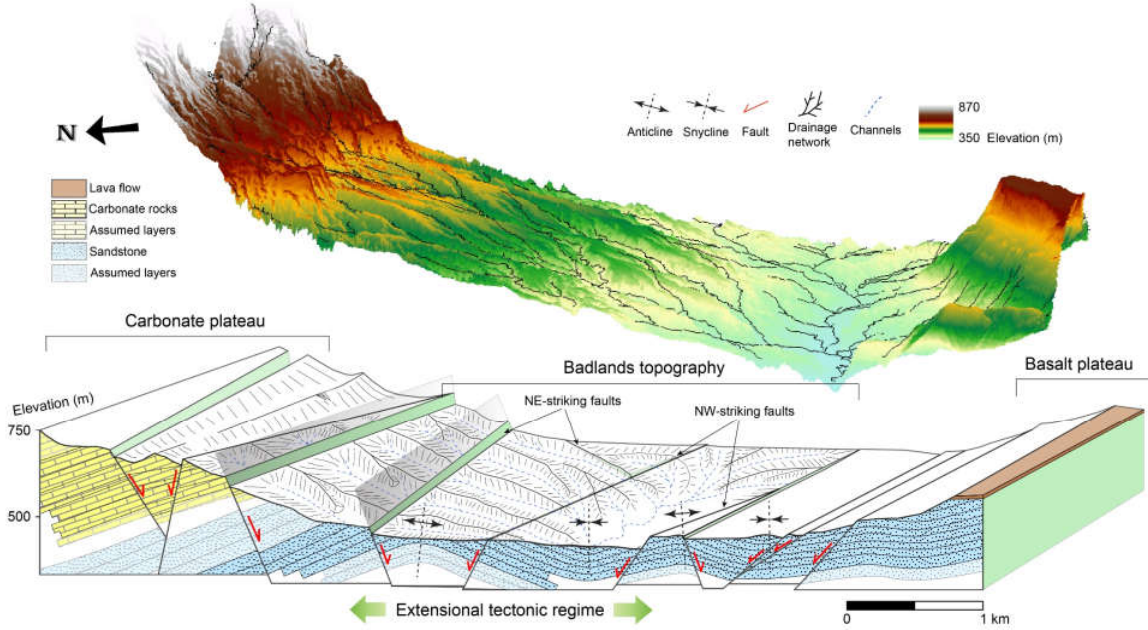
Figure 14. Tectonic block diagram highlighting extension-related fault development in the Kula Basin. Adapted from [90]. Rock structure and faulting are indicated with arrows. Actual fault and bedding measurements were used to construct the diagram. See Figure 10 for other cross sections and rose diagrams. The erosive landscape shown as a conceptual sketch is only to indicate the relationship between faulting vs. conceptual gully network.